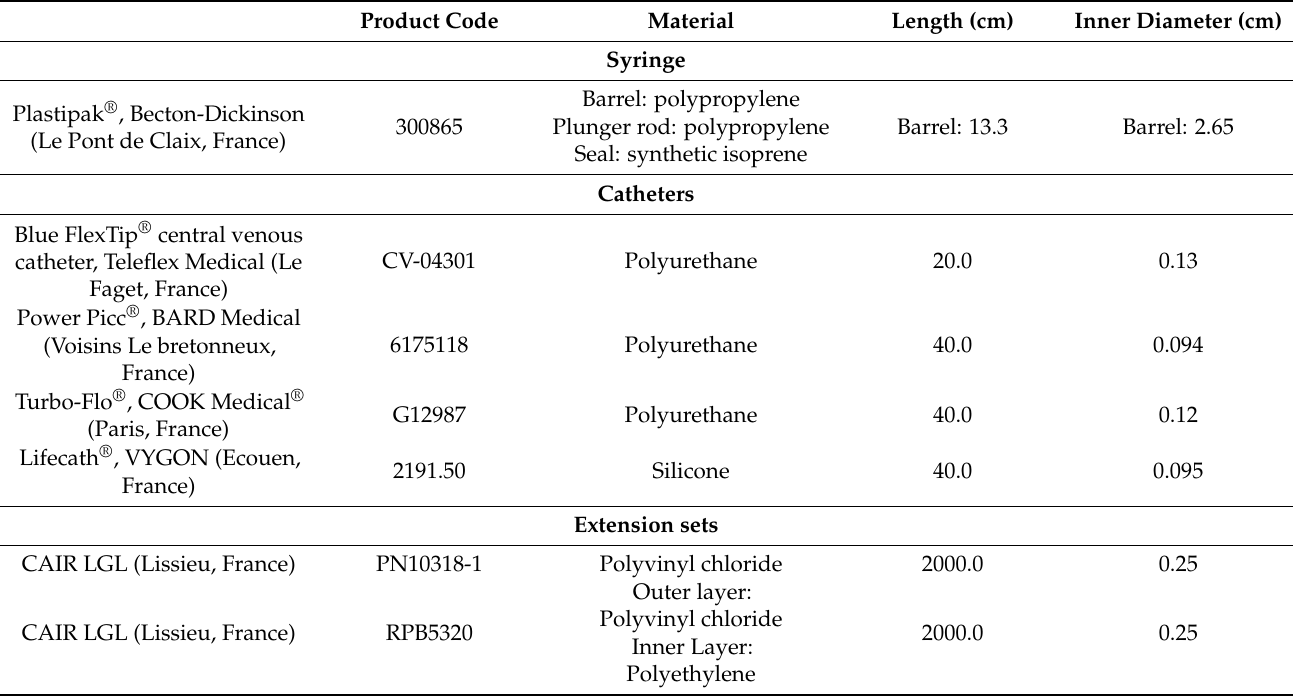
Table 1. Summary of the studied medical devices and their